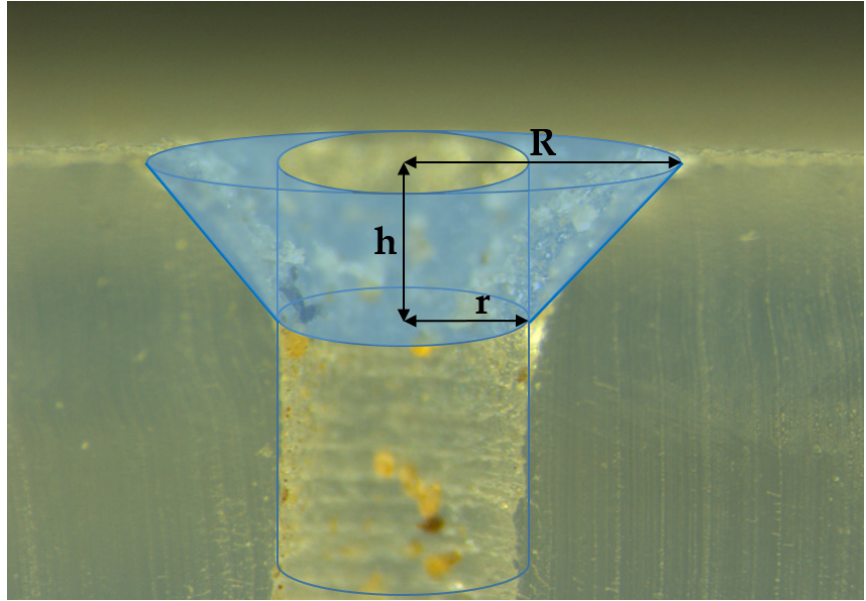
Figure 3. Transversal cut of a damaged silicon diaphragm showing the “truncated cone” caused by ant activity; R: radius of the top surface of the cone; h: height; r: radius of the base (i.e., of the inner orifice of the diaphragm). The volume of the diaphragm eroded by ants is represented in translucent blue.